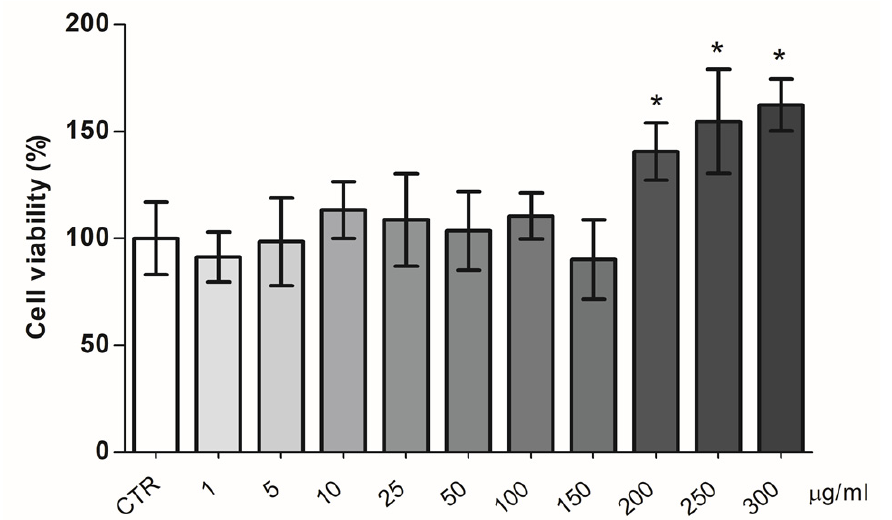
Figure 6. BPF effect on pAECs’ viability. Cells were treated with different doses of BPF for 5 h. * p < 0.05, one-way ANOVA, and post hoc Tukey’s test between each treatment vs. control (CTR) group.